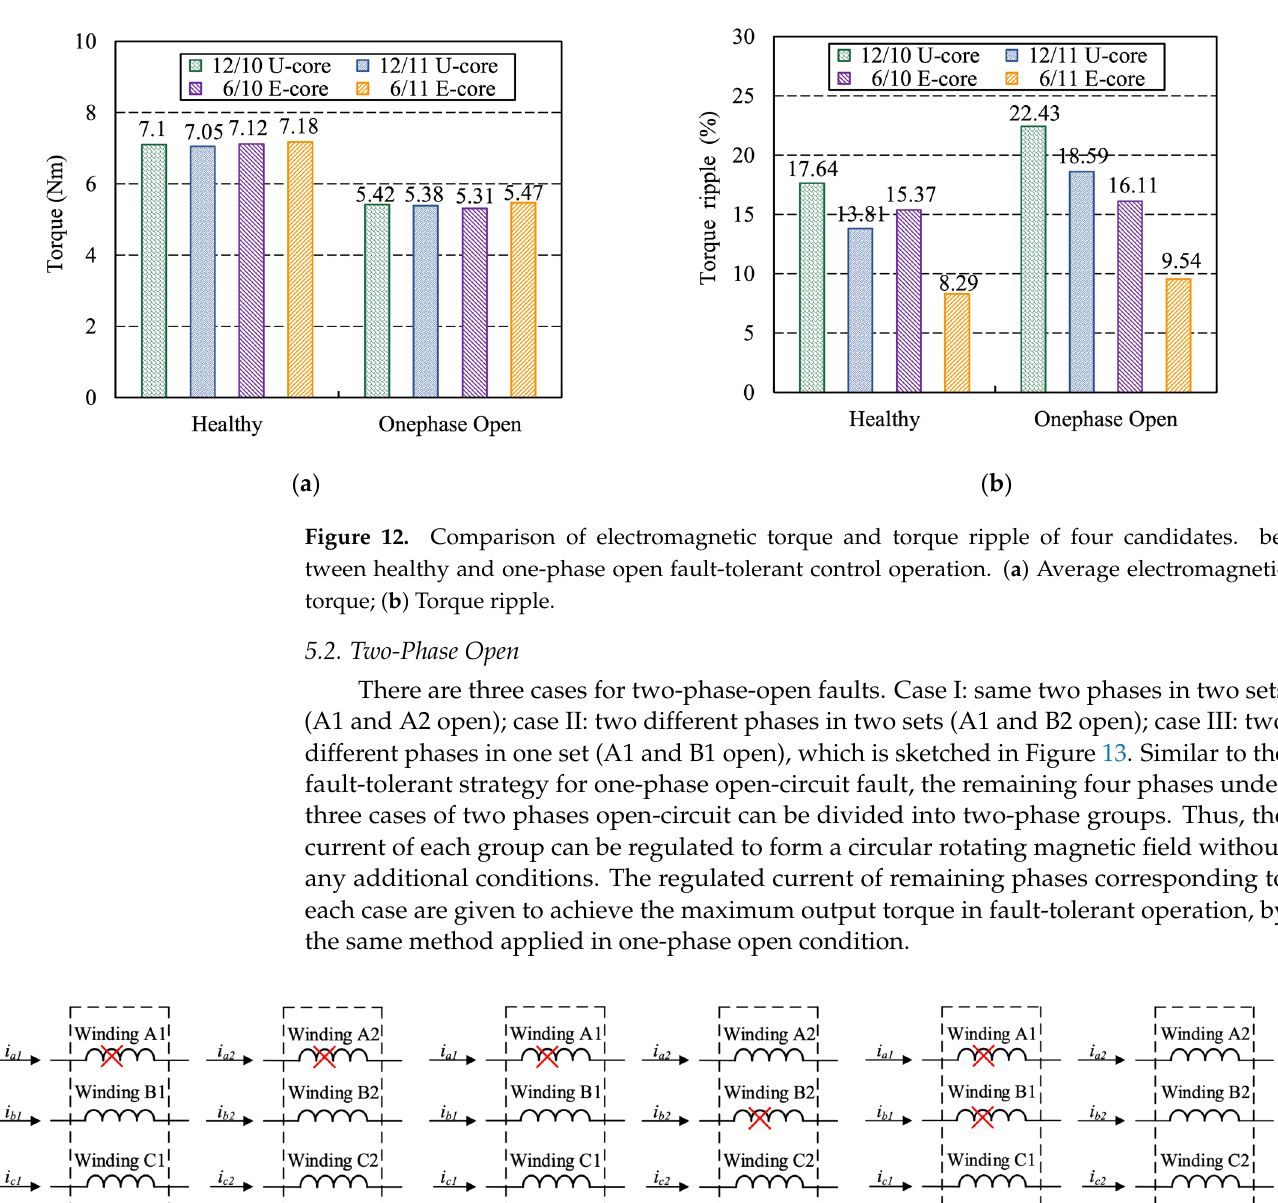
Figure 14. Phase diagram of regulated currents under two-phase open-circuit (Case I: phase A1 and A2 open-circuit) fault-tolerant control.